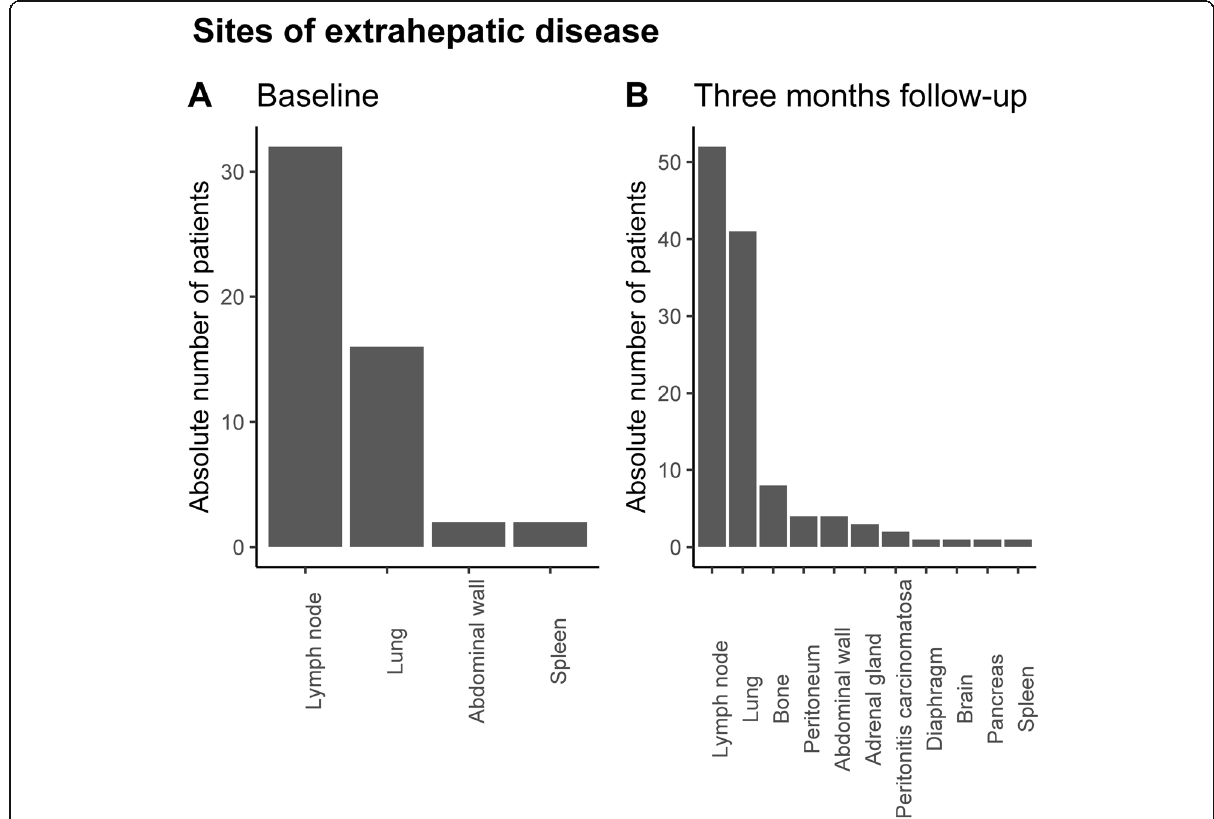
Fig. 1 Site of extrahepatic metastases at baseline and at 3-month follow-up. a Type and number of affected organs in patients with extrahepatic metastases at baseline. Bars depict absolute number of patients. In total, 50 affected organs in 42 patients. b As in a , for 3-month follow-up. In total, 119 affected organs in 67 patients. Lymph nodes and lung are most affected at baseline and 3-month